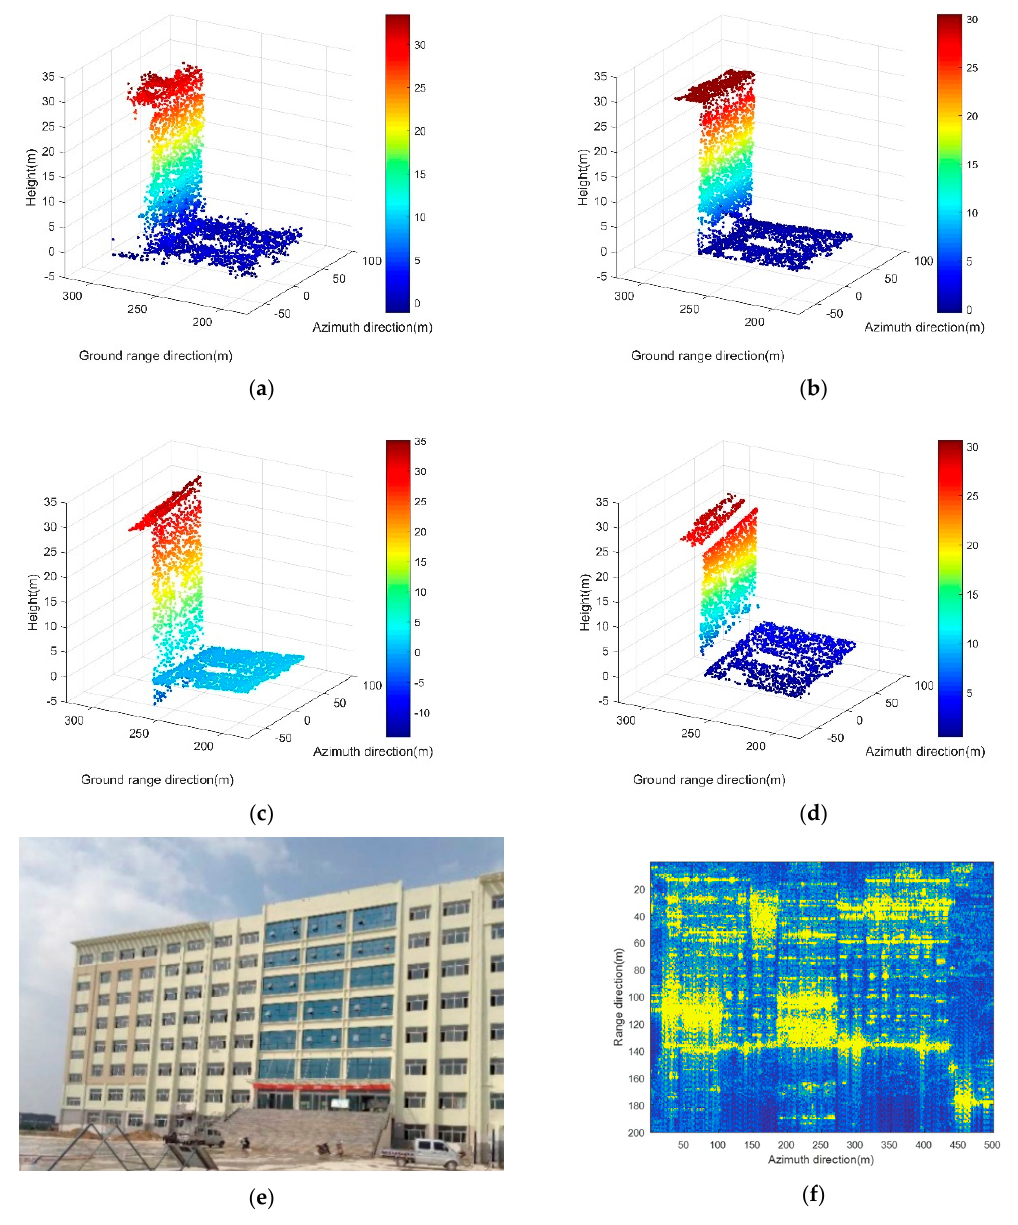
Figure 16. Results on the experimental TomoSAR data. ( a ) Original point clouds of the test building from one side looking. ( b ) Results of our proposed method; ( c ) Results of the RANSAC algorithm; ( d ) Results of the TomoSeed algorithm. ( e ) An optical image of the test area. ( f ) The SAR image of the test area with the Ku band.